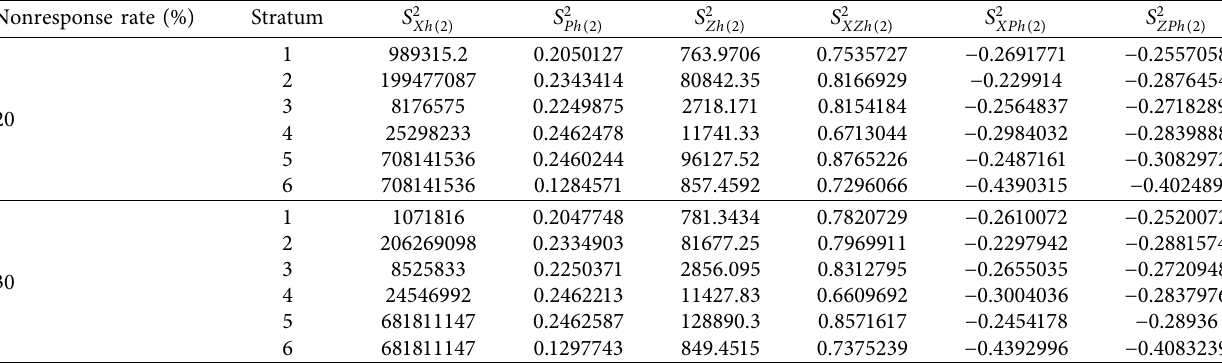
Table 2: Parameters for nonresponding units for population I.